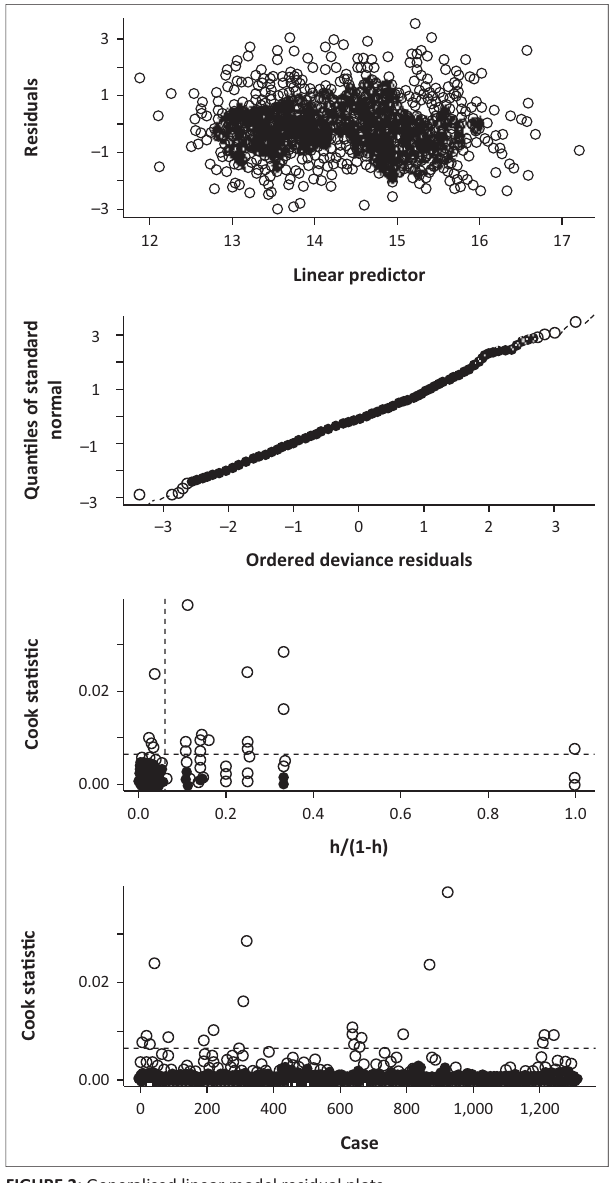
FIG URE 2: Generalised linear model residual